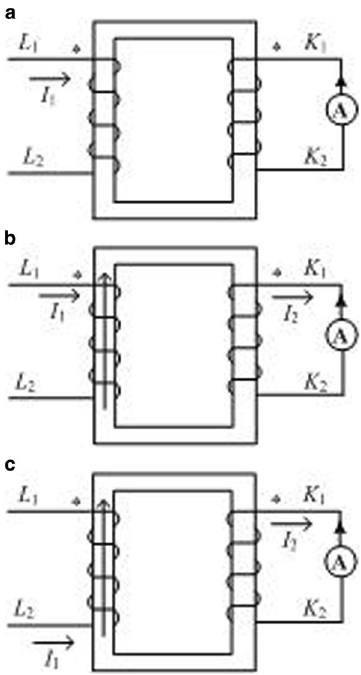
Fig. 7 Current direction acquisition diagram. a Normal operation. b I1 decreases rapidly. c I1 increases